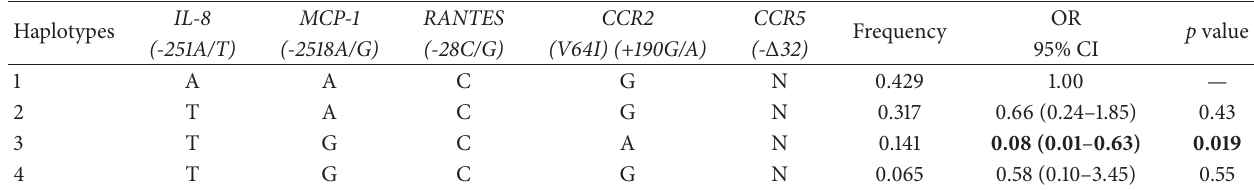
Table 3: Five marker haplotype estimates and odds ratio (OR)